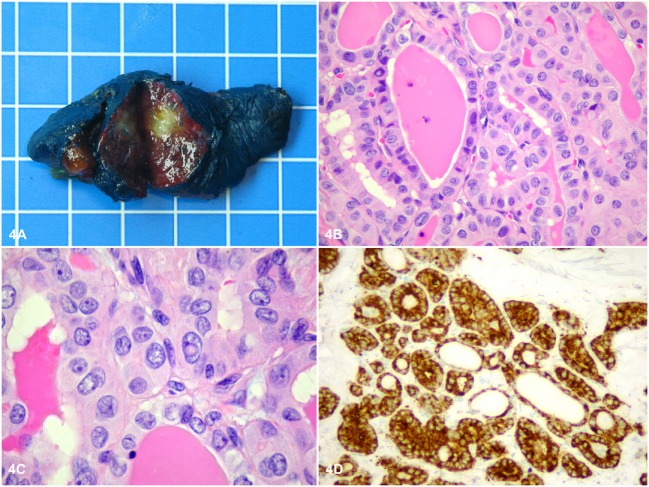
Macroscopically, the thyroid tumor was a rounded, well-circumscribed white intrathyroidal nodule measuring 1.2 cm × 1 cm × 0.8 cm (A). The size of the grid in the background is 1 cm × 1 cm. Microscopically, the tumor consisted of cuboidal cells arranged mostly in follicles with a few papillae, showing classical nuclear features of papillary thyroid cancer (PTC), including chromatin pallor, numerous nuclear grooves, and several nuclear pseudoinclusions (B,C). Further evaluation using immunohistochemistry revealed positive BRAF V600E immunostaining in the tumor cells (D), consistent with the classical type of PTC (BRAF-like PTC).